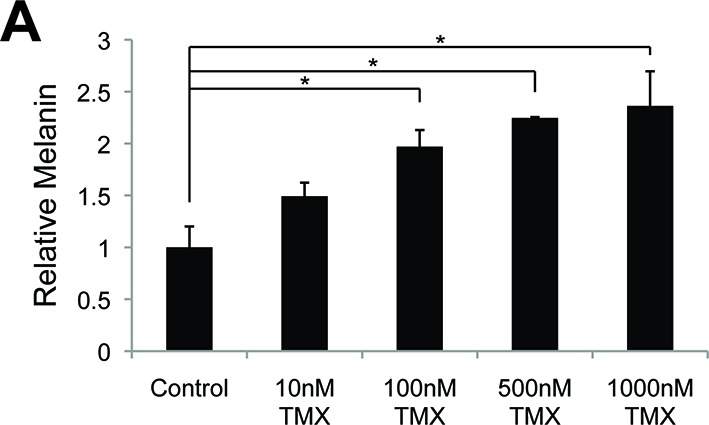
Melanin production is altered by sex steroid analogs currently in clinical use.The effect of clinically relevant GPER agonists. (A) Melanin production in response to tamoxifen (TMX). n=3 biologic replicates for each experiment. Error bars denote +/- s.d., *p<0.05DOI: